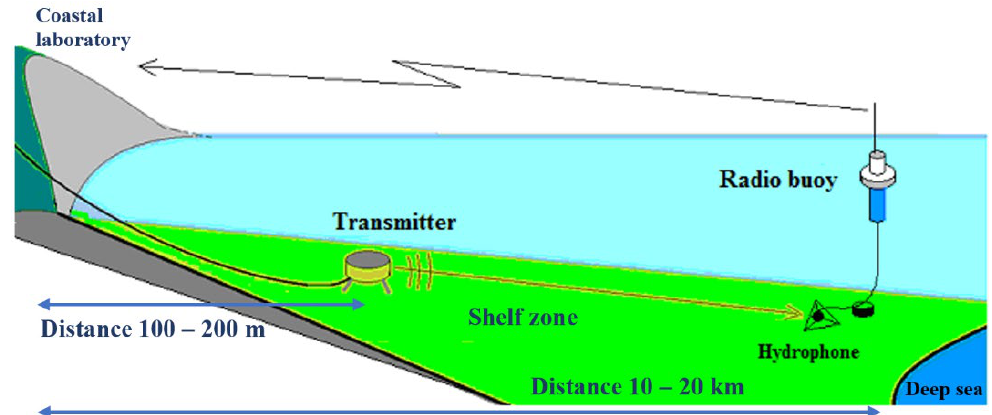
Figure 8. The scheme of the shelf zone monitoring.